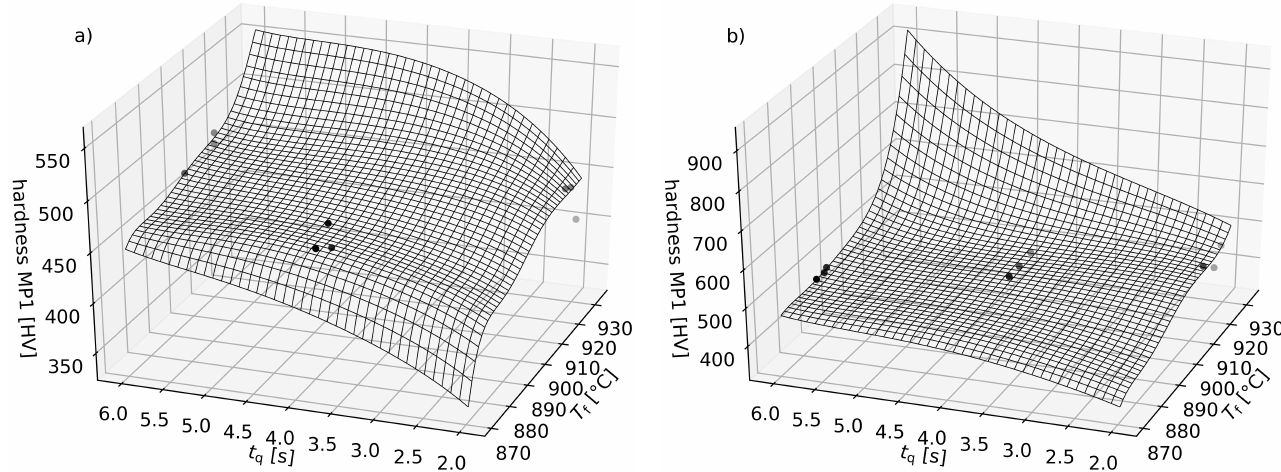
Figure 7. Response surfaces of 4D monotonic regression with SIAMOR ( m = 6) for forming and press hardening of sheet metal ( ∆ t h = 0s). The markers represent those training points matching the specifications of the corresponding planes in the input space. ( a ) F p = 1750kN, ( b ) F p =